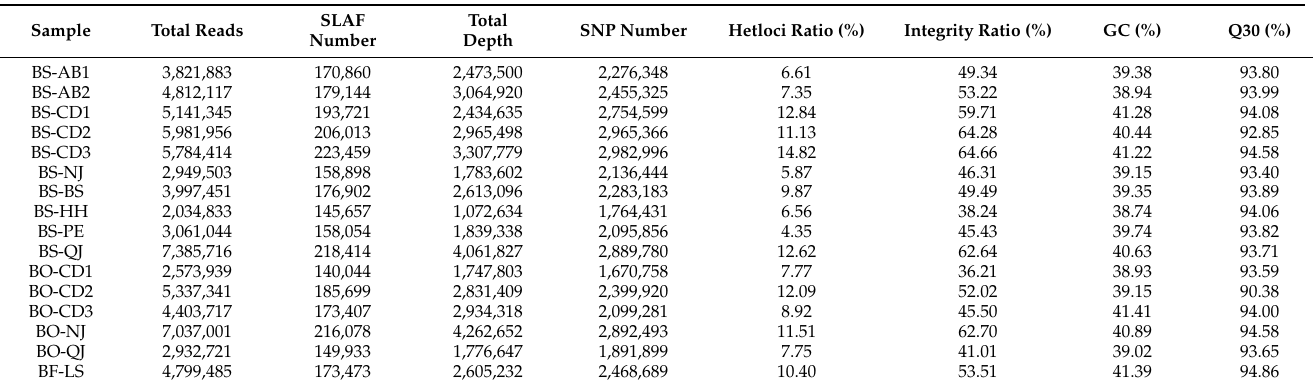
Table 2. SLAF tag statistics for the samples and SNP information